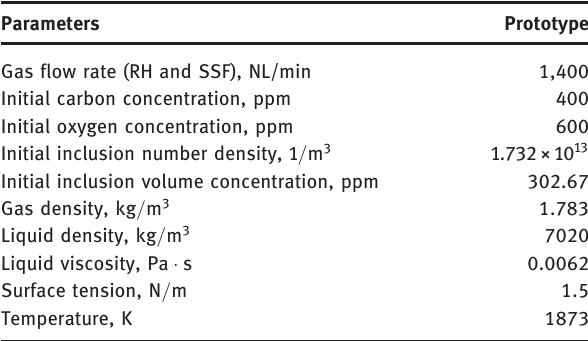
Table 2: Calculation and property parameters. Parameters